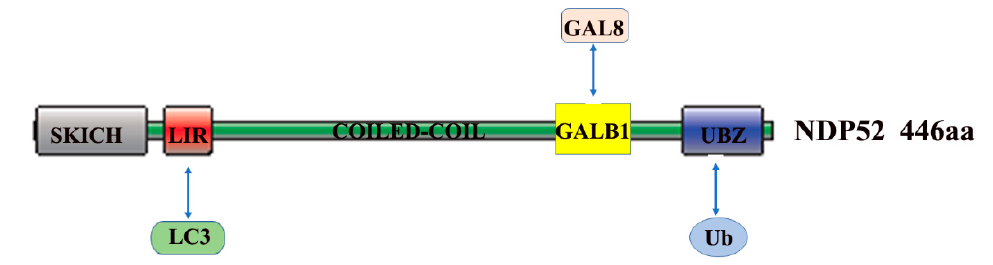
Figure 2. of NDP52. NDP52 contains 446 amino acid (aa), including the domains of SKICH, LC3-interaction region (LIR), COILED-COIL, GALB1, and UBZ. UBZ domain interacts with Ub, identifies and binds autophagy substrates. LIR domain interacts with LC3 and assists substrate anchoring to autophagosome membranes. GALB1 domain interacts with GAL8 (modified from reference [30]).